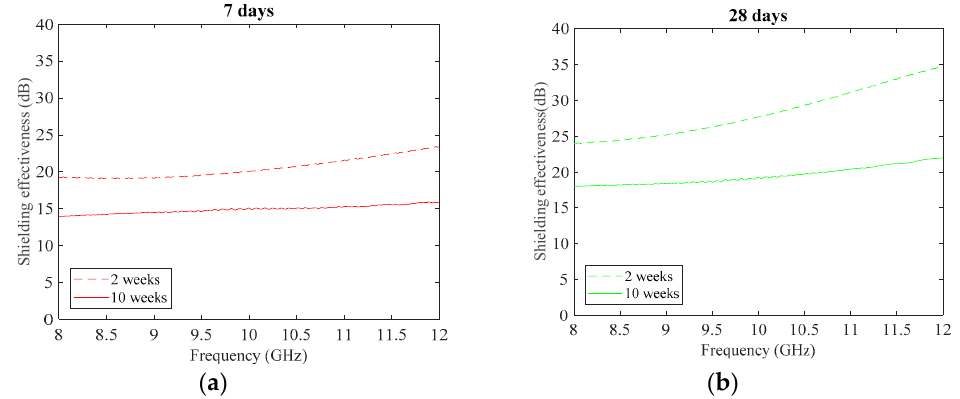
Figure 8. Measured shielding effectiveness of cement sample with 18 wt.% biochar: (a) cured in water for seven days; ( b ) cured in water for 28 days. Measurements were performed after two weeks and 10 weeks.